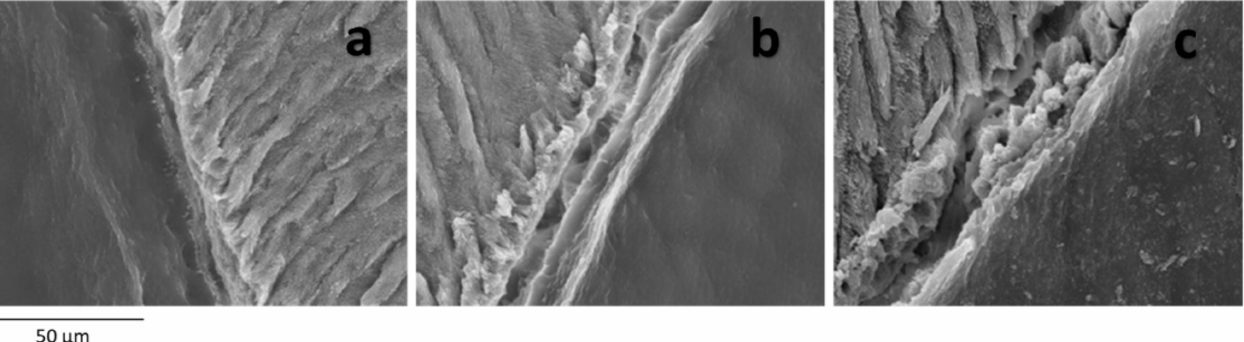
Figure 2. DEJ. SEM photomicrographs with original magnification of 1000 × . Image of a normal DEJ, with union between enamel and dentin ( a ), clean continuity solution between enamel and dentin with a clean gap between enamel and dentin without tissue adhesions ( b ) and fracture of enamel and dentin with remains of enamel prisms adhered to dentin ( c